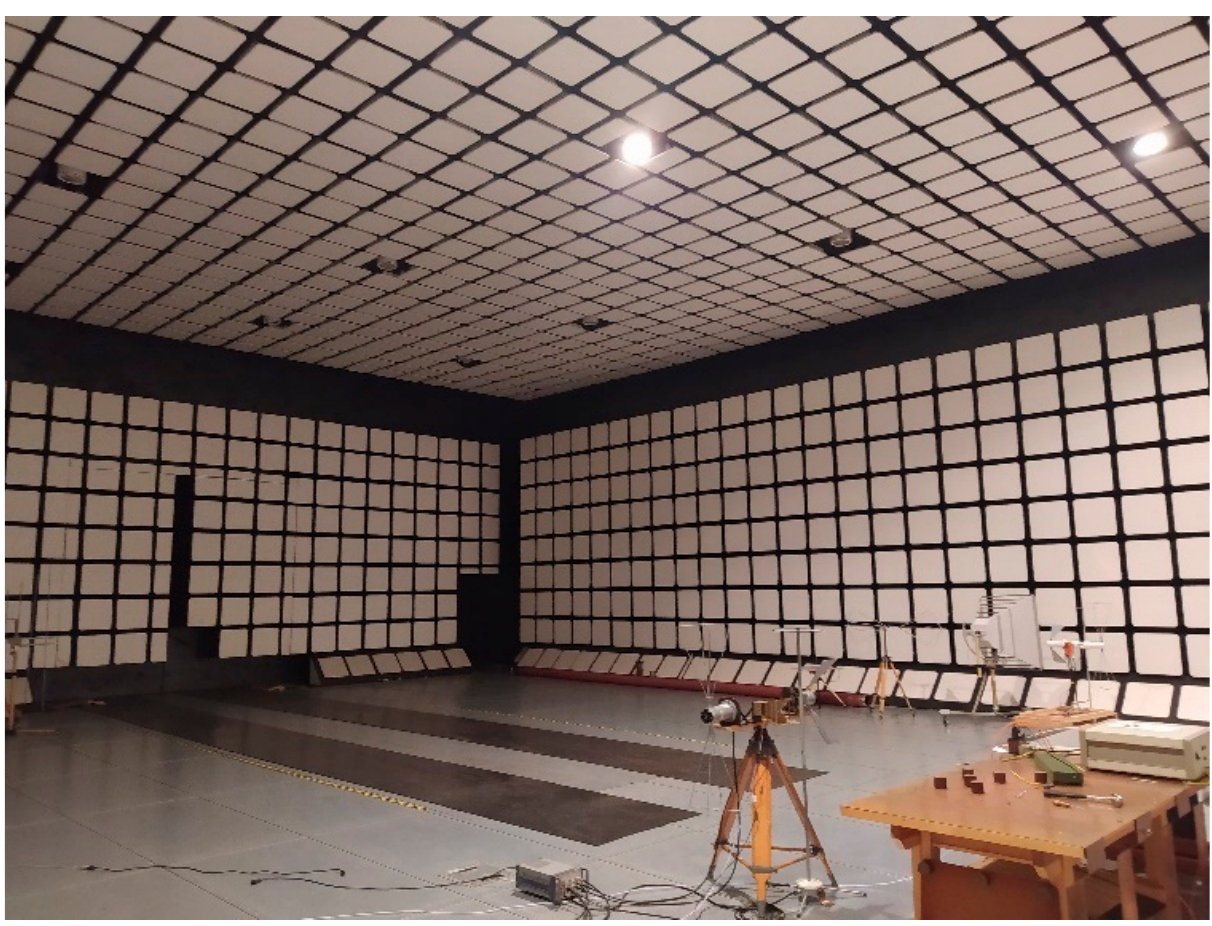
Figure 2. An example of anechoic chamber.